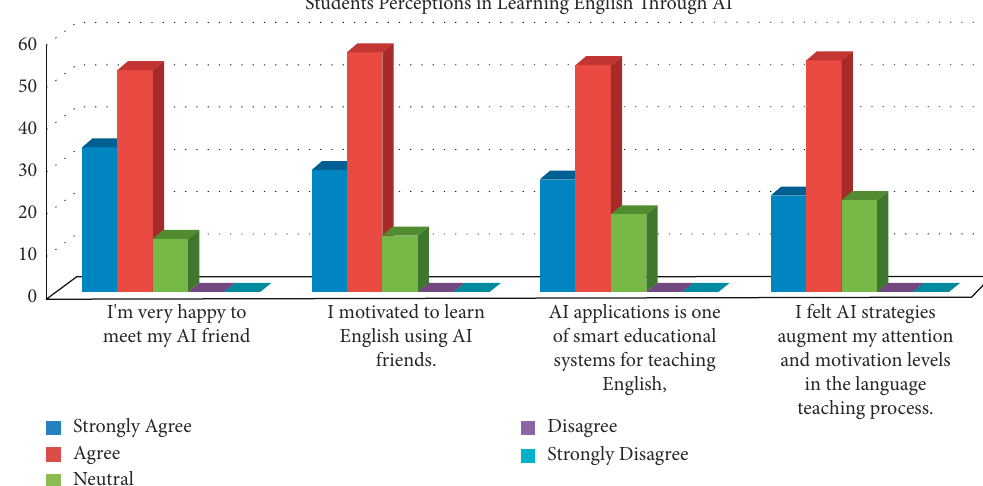
Figure 3: Students’ perceptions in learning through AI